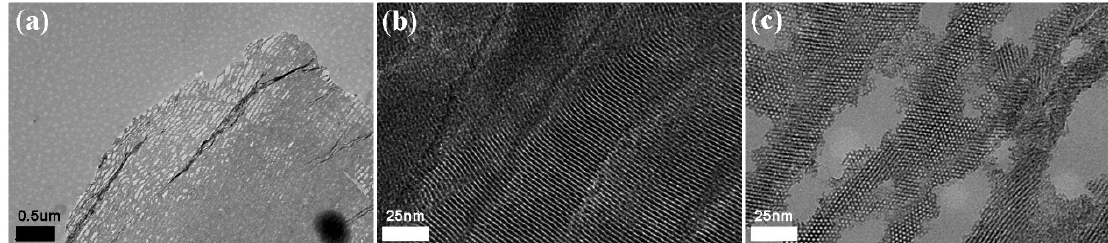
Figure 5. TEM micrograph of the ultramicrotomed MFB embedded in resin. The microstructure of the MFB retained ( a ) a nanofibrous structure; ( b ) long one-dimensional channels; and ( c ) a highly ordered 2D hexagonal structure. The magnification of ( a ) ×10 k, scale bar = 0.5 µm; ( b , c ) ×250 k, scale bar = 25 nm. scale bar = 25 nm.